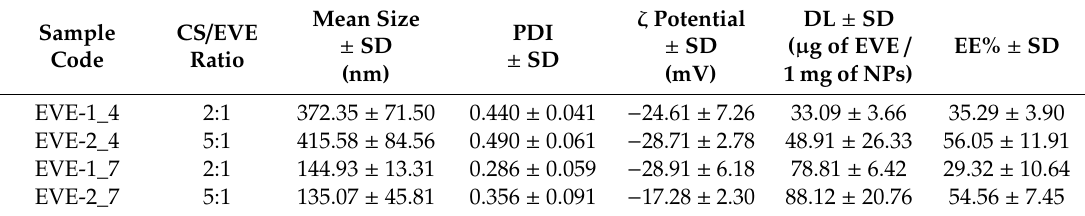
Table 3. Physical characterization and Everolimus (EVE) encapsulation of EVE loaded HA / CS